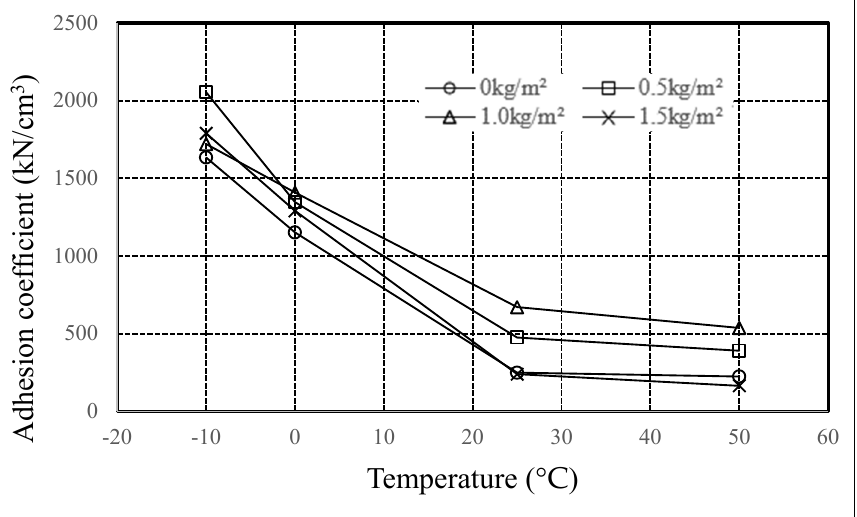
Figure 9. Influence of temperature on the bonding coefficient of oil A bond specimen.